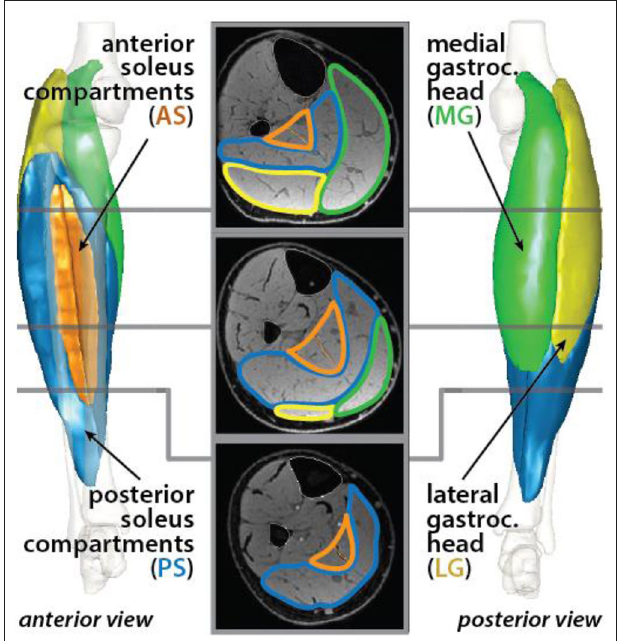
FIGURE 1 | Triceps surae muscles were segmented in axial MR images. The muscle cross sections were defined for the medial (green) and lateral (yellow) heads of the gastrocnemius and the posterior (blue) and anterior (orange) compartments of the soleus. Each muscle was reconstructed in 3-D.